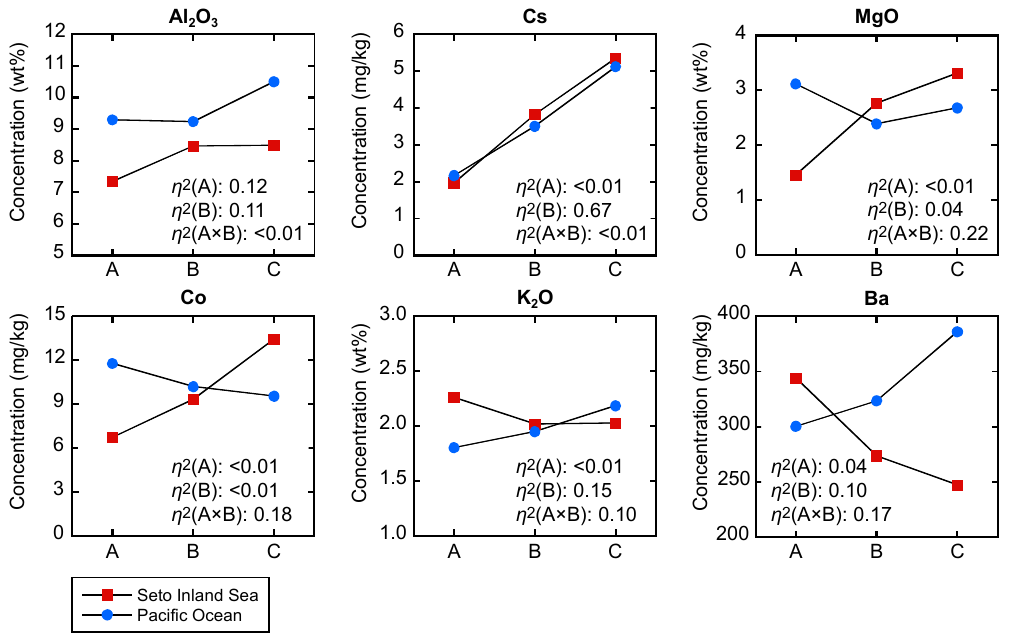
Figure 5. Median concentrations of elements and oxides in sediments from the Seto Inland Sea and the Pacific Ocean. A, B, and C represent coarse sediment, fine sand, and silty ‐ clayey sediments, respectively. η 2 (A), η 2 (B), and η 2 (A × B) are the size effects of regional differences, particle sizes, and the interaction effect, respectively, obtained from the two ‐ way ANOVA (Table 4).